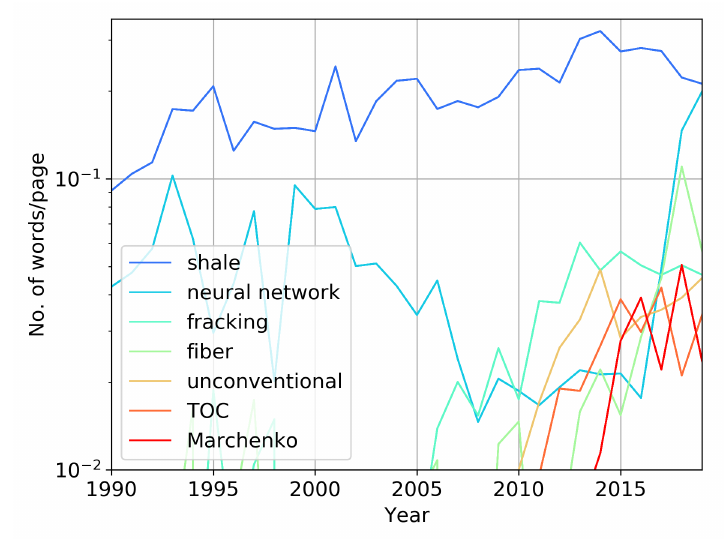
Figure 14. The summary graph describing our main conclusions. “Fracking” curve includes